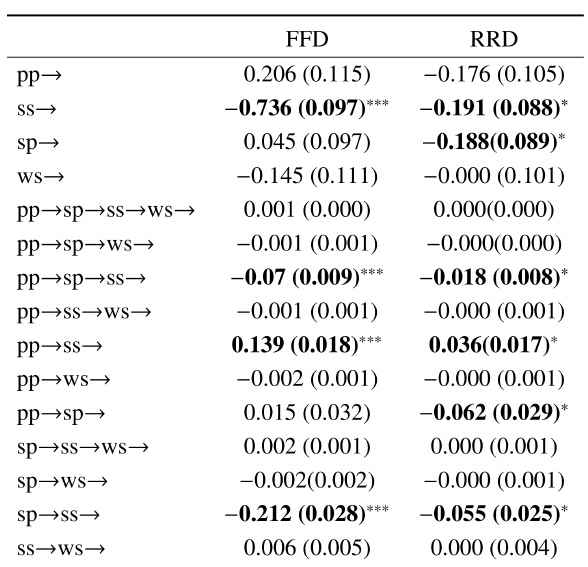
Table 5. Estimates (and their standard errors) for the path analyses of the impact of the similarity measures on FFD and RRD dependent measures. Note that pp = paragraph_paragraph similarity; sp = sentence_paragraph similarity; ss = sentence_sentence similarity; ws = word_sentence